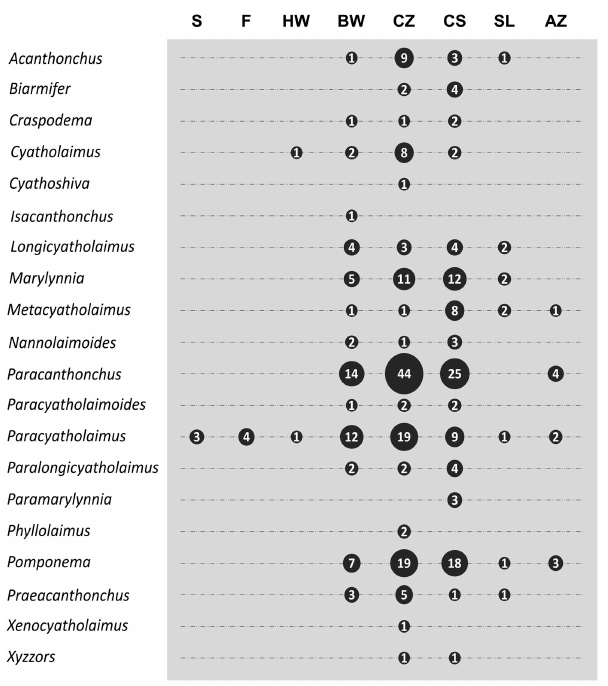
FIGURE 6 | The number of species registered in each habitat by genus. S, Soil; F, Freshwater; HW, Hypersaline Water; BW, Brackish Water; CZ, Coastal Zone; CS, Continental Shelf; SL, Continental Slope; AZ, Abyssal Zone.